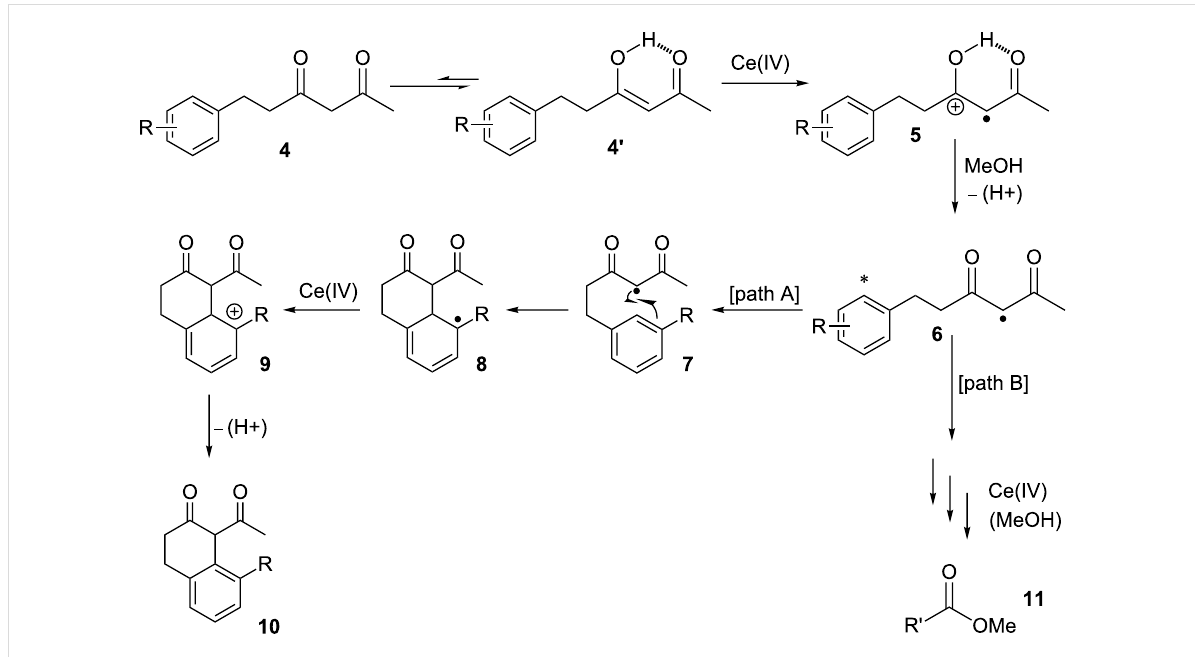
Scheme 2: Proposed mechanism for the conversion of δ -aryl- β -dicarbonyl compounds to β -tetralones (path A) and methyl esters (path